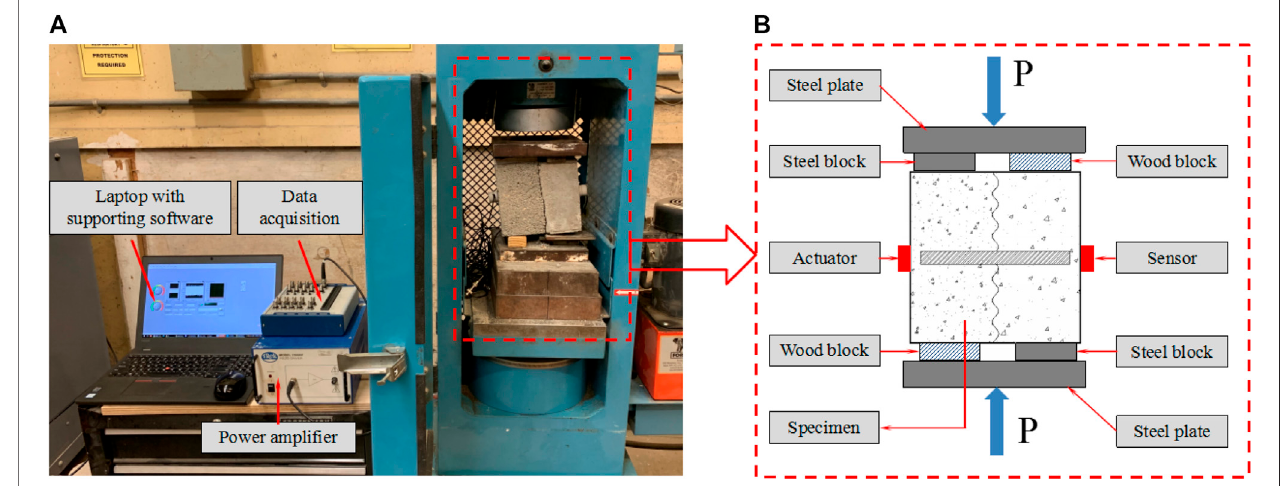
FIGURE5| Experimental setup oftheexperimentaltest. (A) Theoverall diagram ofexperimental setup; (B) Thedetailsofthe spencimen inthe experimental setup.